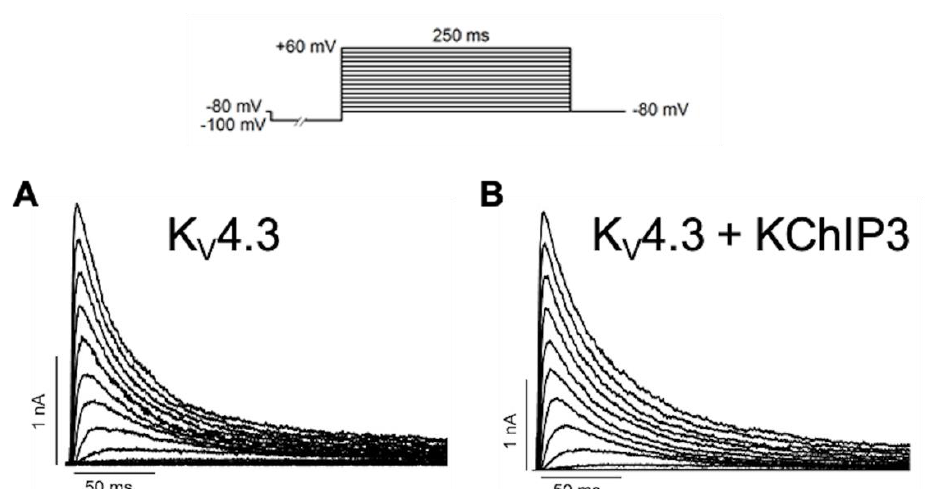
Figure 5. Original K V 4.3 ( A ) and K V 4.3+KChIP3 ( B ) records generated after applying the pulse protocol shown in the upper part of the Figure. Note that K V 4.3+KChIP3 channels exhibit a slower inactivation rate than K V 4.3 ones.